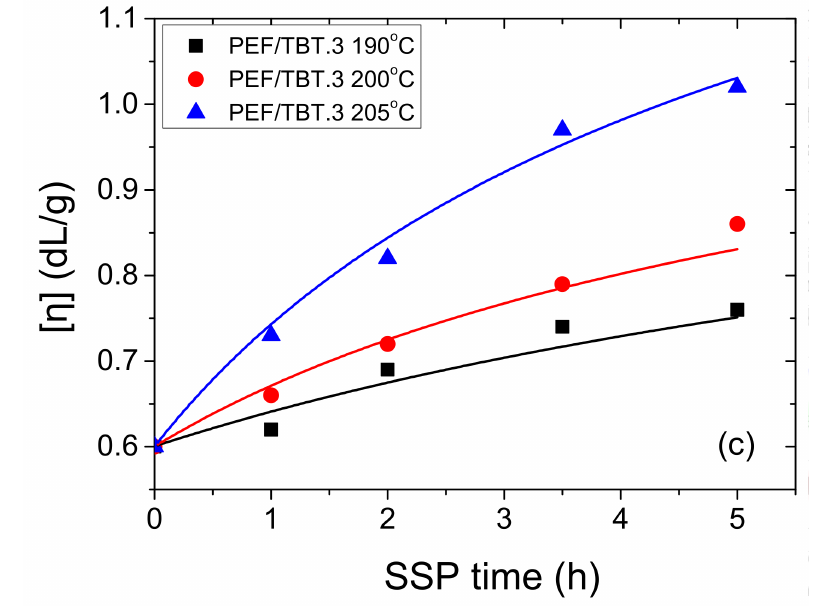
Figure 2. Variation of the intrinsic viscosity with time during solid-state polymerization (SSP) of PEF using TBT catalyst and three different initial IV values; PEF/TBT.1 ( a ), PEF/TBT.2 ( b ), and PEF/TBT.3 ( c ) at different temperatures. Continuous lines represent the theoretical kinetic model simulation results.